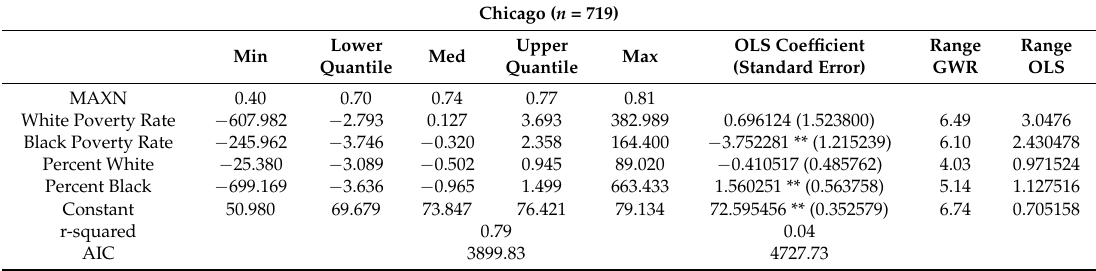
Table 6. Global and Local Parameter Estimates of the Geographically Weighted Regression Model for Chicago.